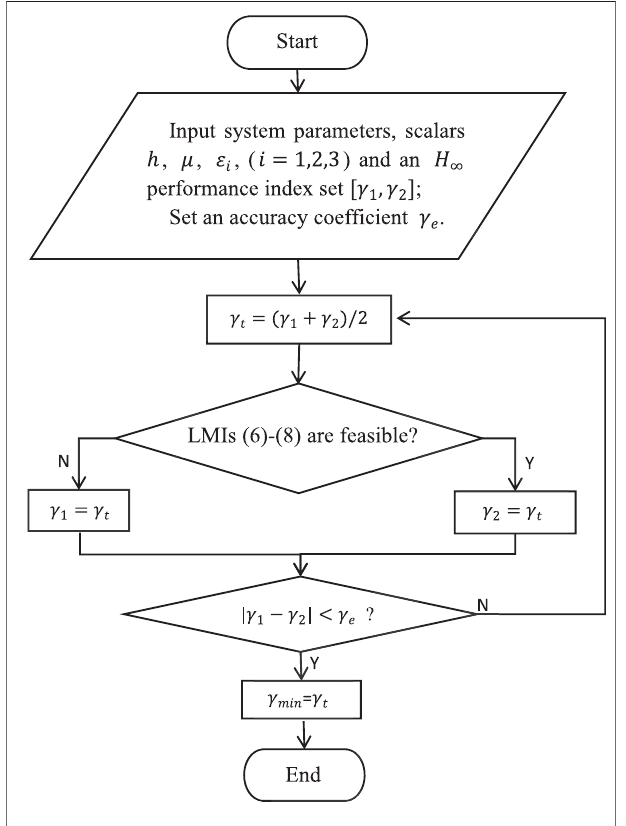
FIGURE 2 | Binary search optimization for solving optimal performance index.